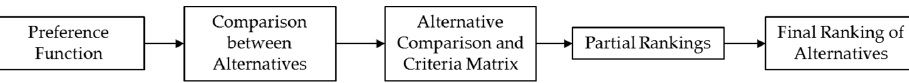
Figure 3. PROMETHEE methodology.